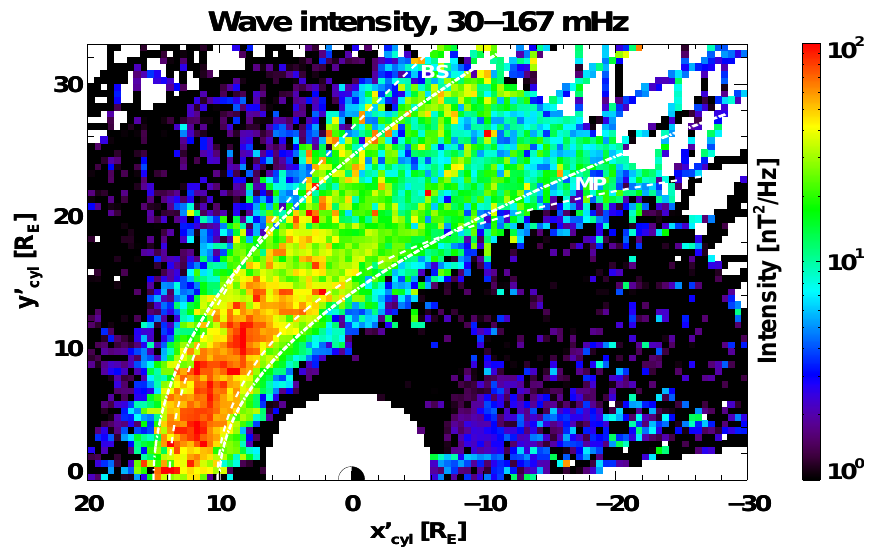
Fig. 2. Spatial distribution of the wave intensity in the frequency range 30 to 167mHz (after Guicking, 2011). The underlying THEMIS magnetic field data are shown in Fig. 1 as well as the bow shock (BS) and magnetopause (MP) models.